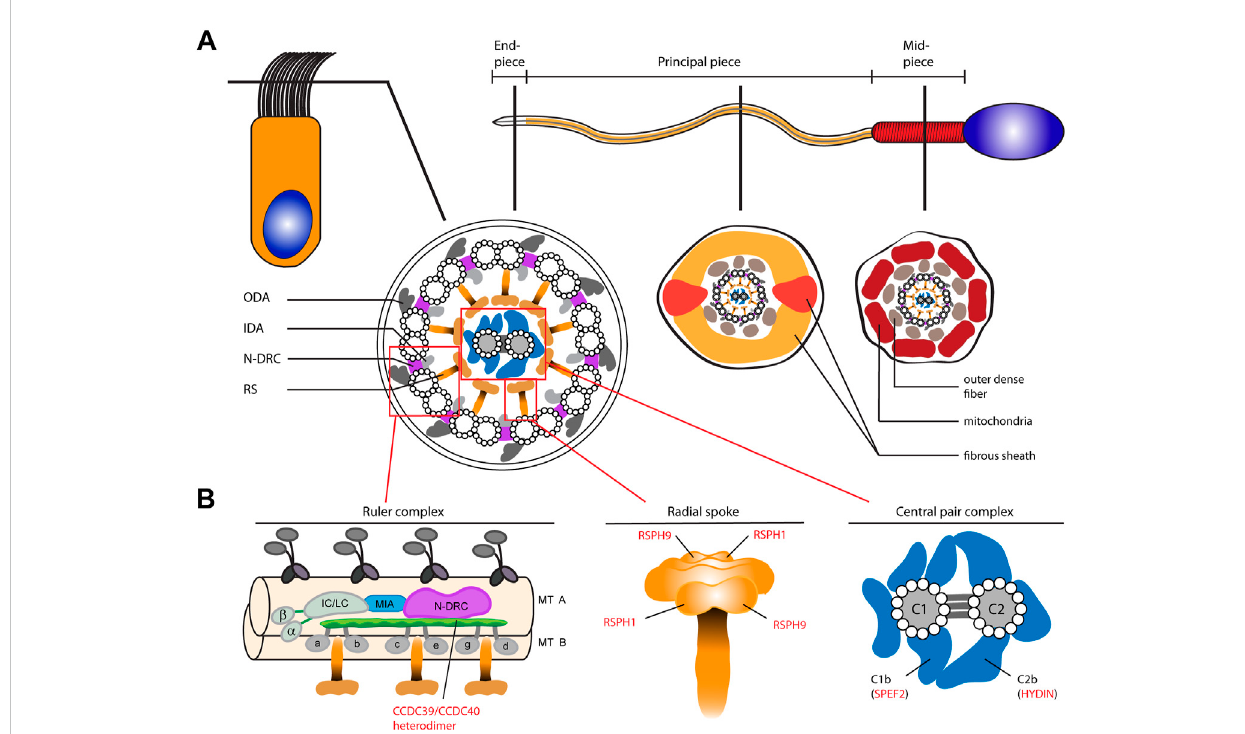
Schematic of the composition of motile 9 + 2 cilia and sperm fl agella as well as representation of selected functional axonemal protein complexes involved in ciliary and fl agellar beat regulation. (A) The upper panel shows a schematic representation of a ciliated respiratory epithelial cell (left) and a sperm cell (right). The sperm fl agellum is divided into three regions; the mid piece, principal- and end piece. The middle panel shows cross sections through a respiratory cilia and the sperm fl agellum. Both share a 9 + 2 axoneme composed of nine outer microtubule doublets (A- and B-tubule) surroundingacenteredsinglepairofmicrotubules.EachouterA-tubulecarriesdyneinbasedmotorproteincomplexes,theouter-andinnerdyneinarms (respectively ODA and IDA). A nexin-link dynein regulatory complex (N-DRC) interconnects the outer doublets, while radial spoke (RS) complexes connect them to the central pair (CP) complex. In the sperm fl agellar principal- and mid-piece the axoneme is additionally surrounded by accessory structures, suchas theouter dense fi bers (ODFs), the fi brous sheath (FS) and the mitochondrial(MT) sheath. (B) The lower panel shows schematics ofthe axonemal ruler, the RS and the CP complex. The ruler complex is representatively depicted in a longitudinal section of the axoneme. CCDC39 and CCDC40formaheterodimerthatissupposedtobelocatedattheinterfaceoftheN-DRCandIDAs(composedofdoubleheadedIDAI1withheavychains α and β and the intermediate- and light chain (IC/LC) complex, and single headed IDAs a-e, and g) (Olbrich et al., 2015; Yamamoto et al., 2021). The RS complex is composed of a stalk and a head structure. RSPH1 and RSPH9, here highlighted, are known to be components of the RS head in human respiratory cilia (Frommer etal., 2015).The CP-complexis composed of twocentralmicrotubules connected bythree intermicrotubular bridges. Several protein complexes are associated with the CP, e.g., the C1b and C2b projections, containing the proteins SPEF2 and HYDIN, respectively. In human respiratory cilia localization of SPEF2 depends on functional HYDIN (Cindri ć et al.,